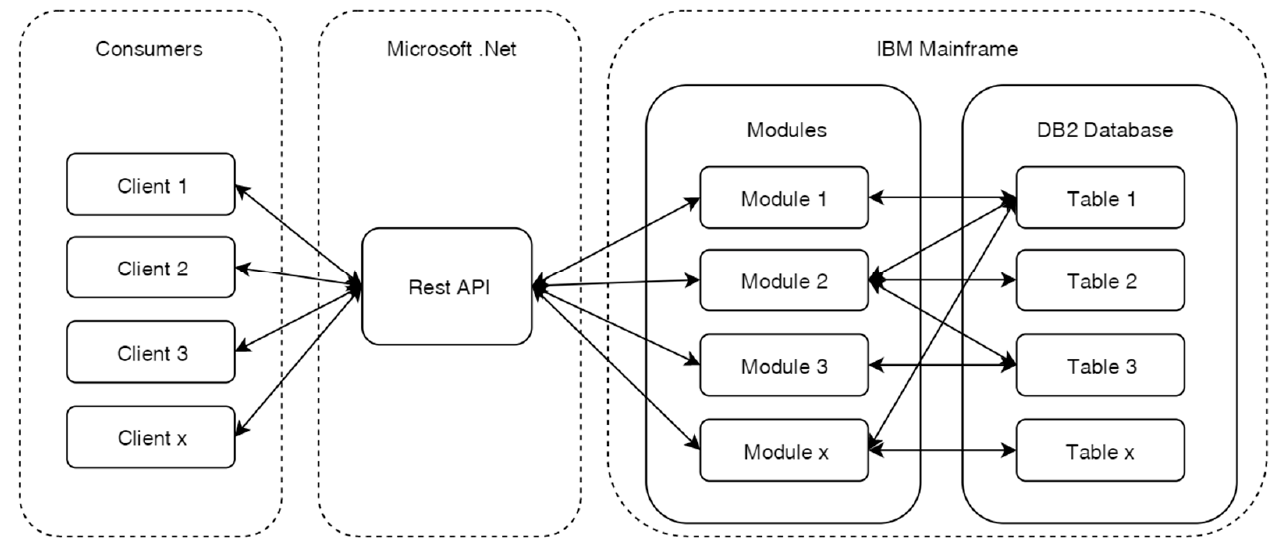
Figure 12. The simplified model of the SSI application.